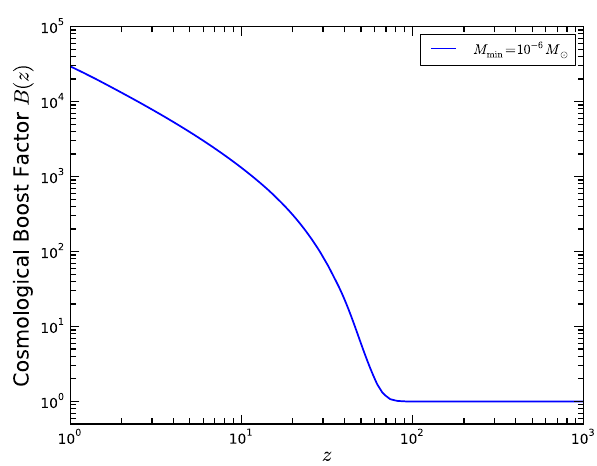
Fig. 8 Cosmological boost factor B ( z ) as a function of redshift for Maccio concentration model with M min = 10 − 6 M (cid:28)